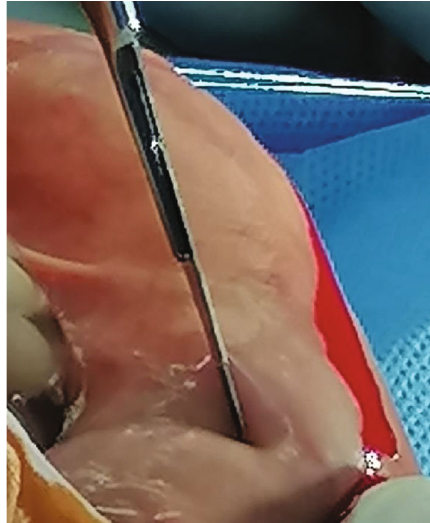
Figure 2: Harvesting oral mucosa graft from the lower lip, and a wheal raised with epinephrine solution.